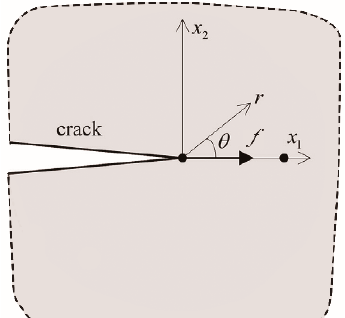
Figure 2. Schematic of the coordinate system for the crack tip.